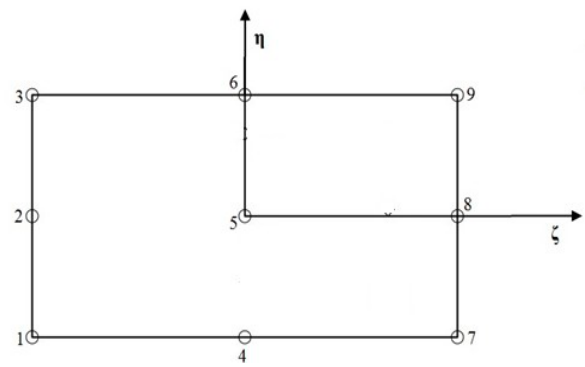
Figure 1. Nine noded curved isoparametric element with typical node numbering.